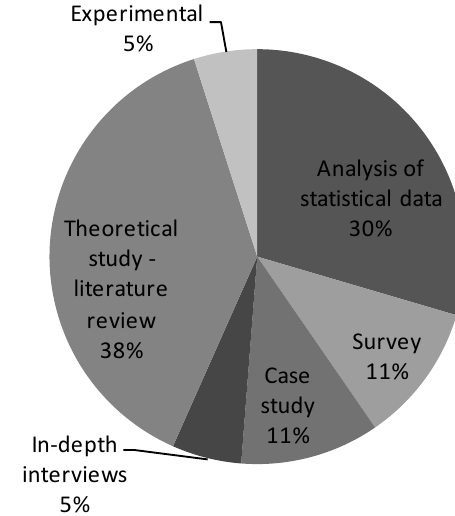
Figure 7: Overall frequency of the occurrence of various research approaches